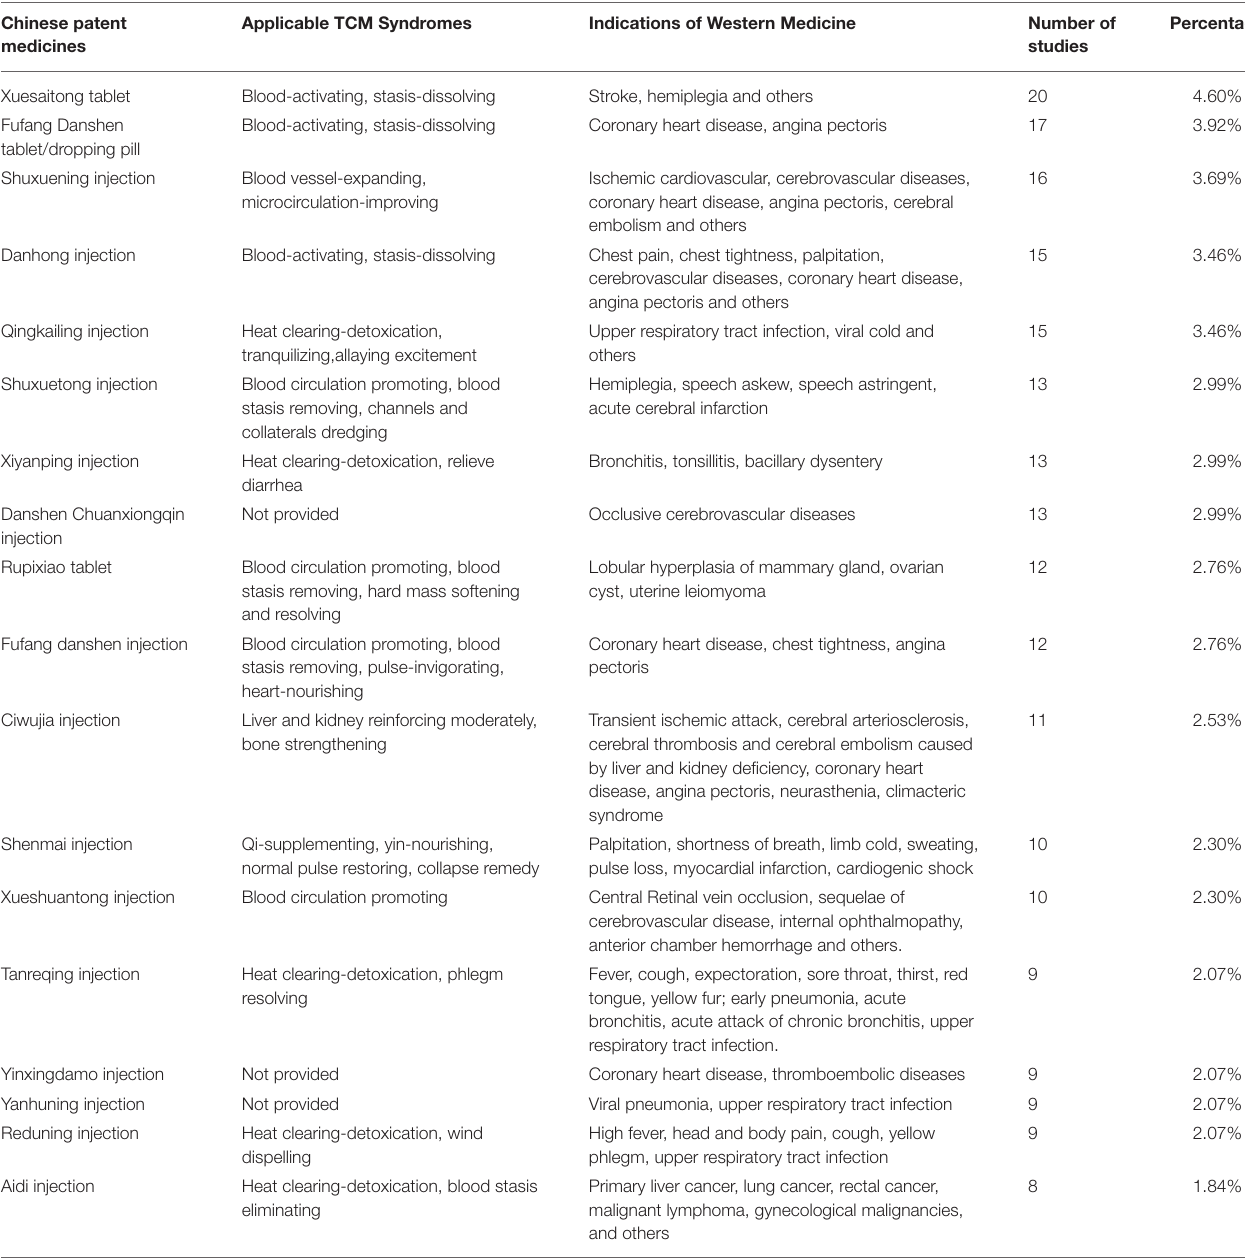
TABLE 2 | Chinese patent medicines with more than eight pharmacoeconomic studies, the TCM syndromes to which they apply, and the Western medicine indicators for these ( N = 434). Chinese patent